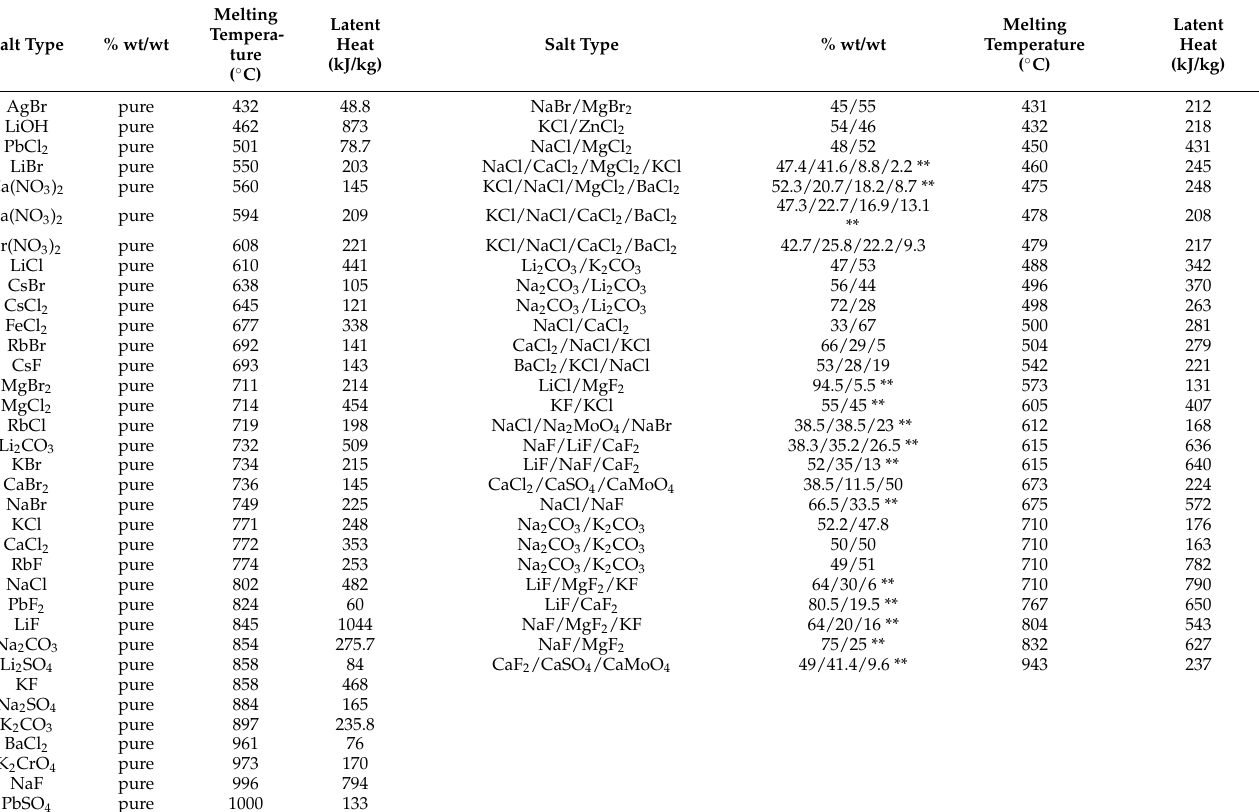
Table 1. Thermophysical properties for pure or mixed molten salts for high-temperature applications [16]. ** % mol/mol.